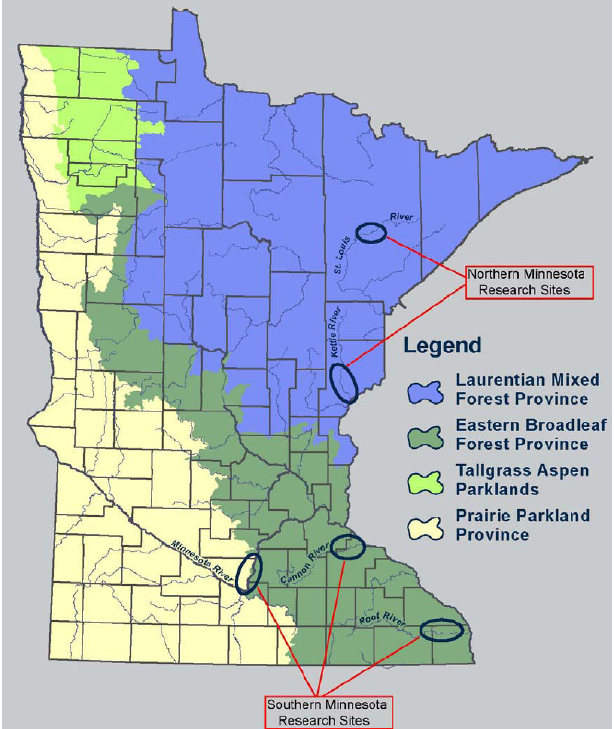
Figure 1. Location of study reaches on five Minnesota Rivers. From north to south the rivers are: the St. Louis, Kettle, Cannon, Minnesota, and Root